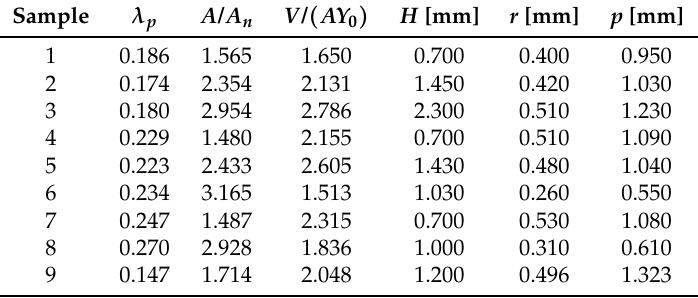
Table 4. Design parameters and geometric characteristics of the cones patterned samples manufactured by laser etching technique: The characteristics of the samples have been defined according to the Taguchi method and the target levels in Table